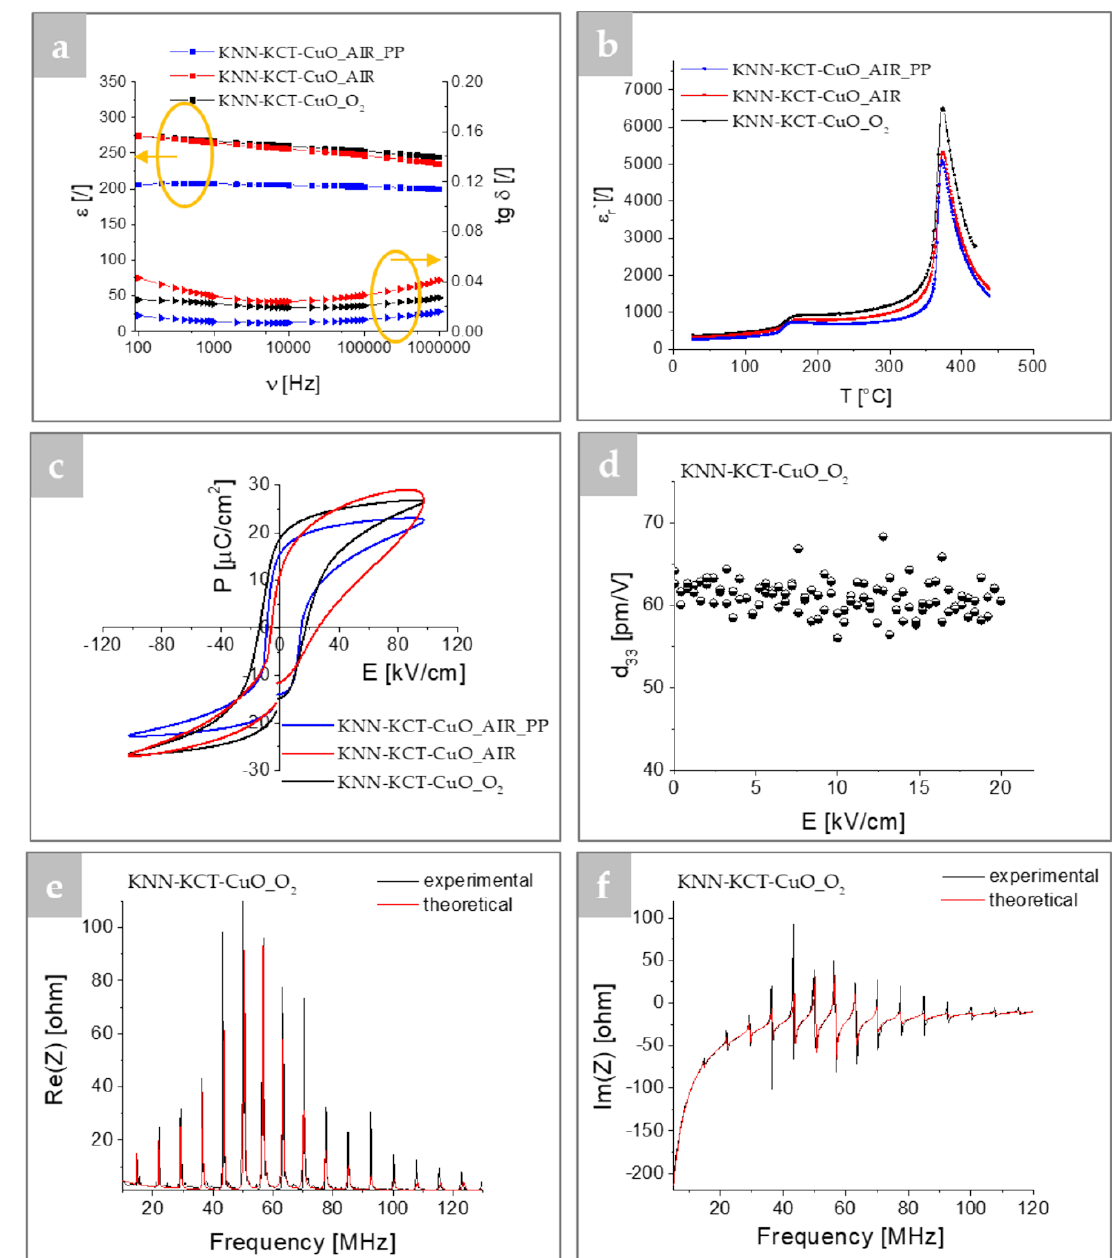
Figure 4. ( a ) Dielectric constant and dielectric losses as a function of frequency at room temperature, ( b ) ε r as a function of temperature measured at 10 kHz and ( c ) polarization hysteresis loops (P-E) measured at room temperature at 10 Hz for thick films sintered in oxygen or in air with and without packing powder. ( d ) d 33 values as a function of dc electric field, ( e ) real and ( f ) imaginary parts of the electrical input impedance as a function of frequency around the fundamental resonance (black line—experimental, red line—theoretical) for the thick film sintered in oxygen, measured at room temperature. The temperature dependence of the dielectric constant for all three thick films at 10 kHz reveals two peaks at ~374 ◦ C and ~172 ◦ C, marking the phase transitions from cubic to tetragonal (T c ) and from tetragonal to monoclinic (T T–M ), respectively, regardless of the use of PP or the sintering atmosphere (Figure 4b). A slight decrease in both tran- sition temperatures of the films is observed compared to KNN-KCT-CuO bulk ceramics (T C ~ 406 ◦ C and T T–M ~194 ◦ C) [36]. This decrease could be related to many parameters, such as substrate confinement, grain size, residual stresses, and defect chemistry